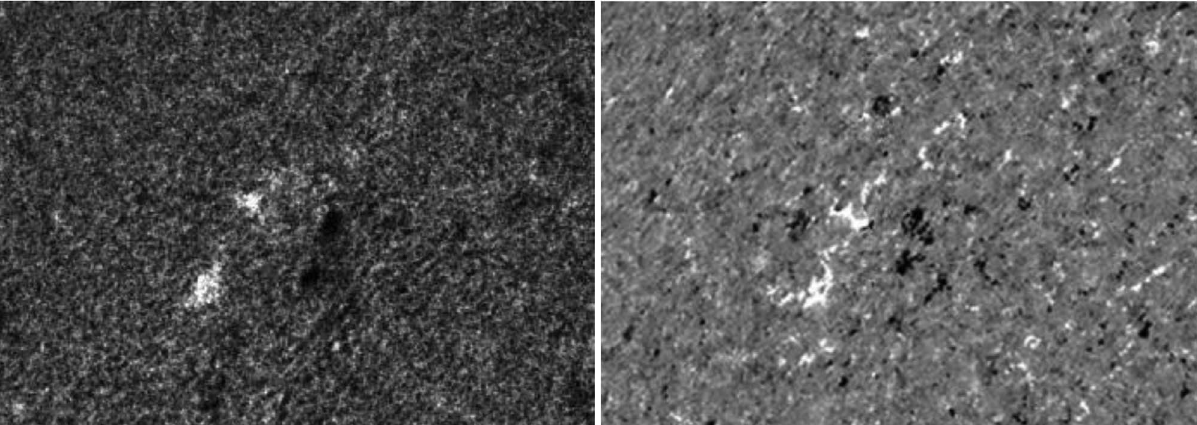
Fig. 10. Comparison between the K magnetogram of SAMM (left) and SDO (right) of the Active region 12,749. (Courtesy of NASA/SDO and the AIA, EVE, and HMI science teams). FOV: 5.5 0 (cid:3) 3.9